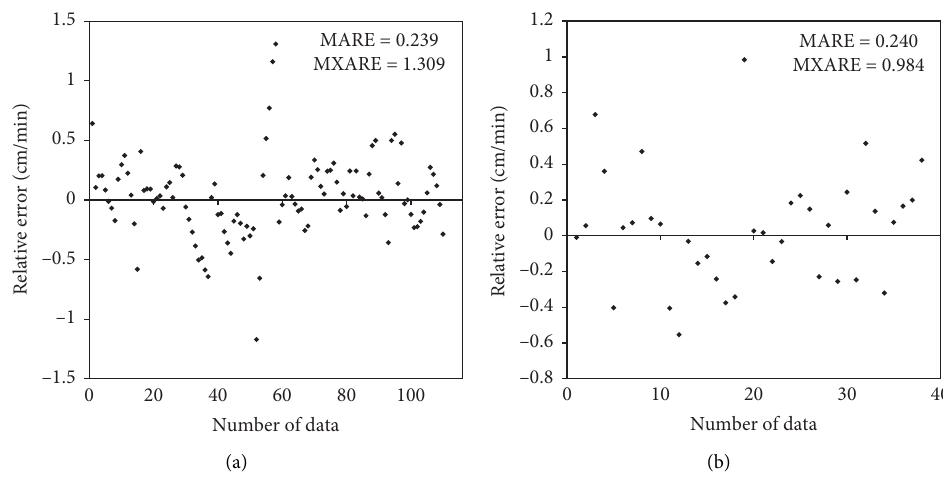
Figure 9: Relative error plots for the MGGP model for the training and testing data.